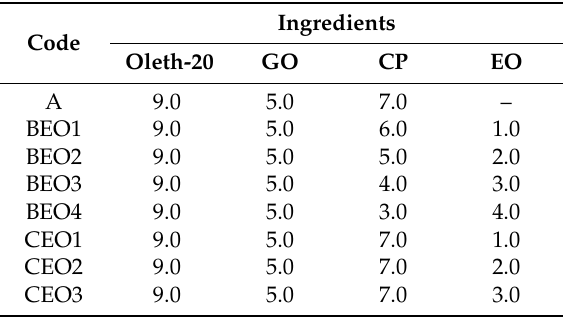
Table 1. Composition (% w / w ) of the lipophilic phase of unloaded and rosemary essential oil (EO)-loaded lipid nanoparticles. Ingredients include Oleth-20, Glyceryl Oleate (GO), Cetyl Palmitate (CP) and essential oils. Ingredients Code Oleth-20